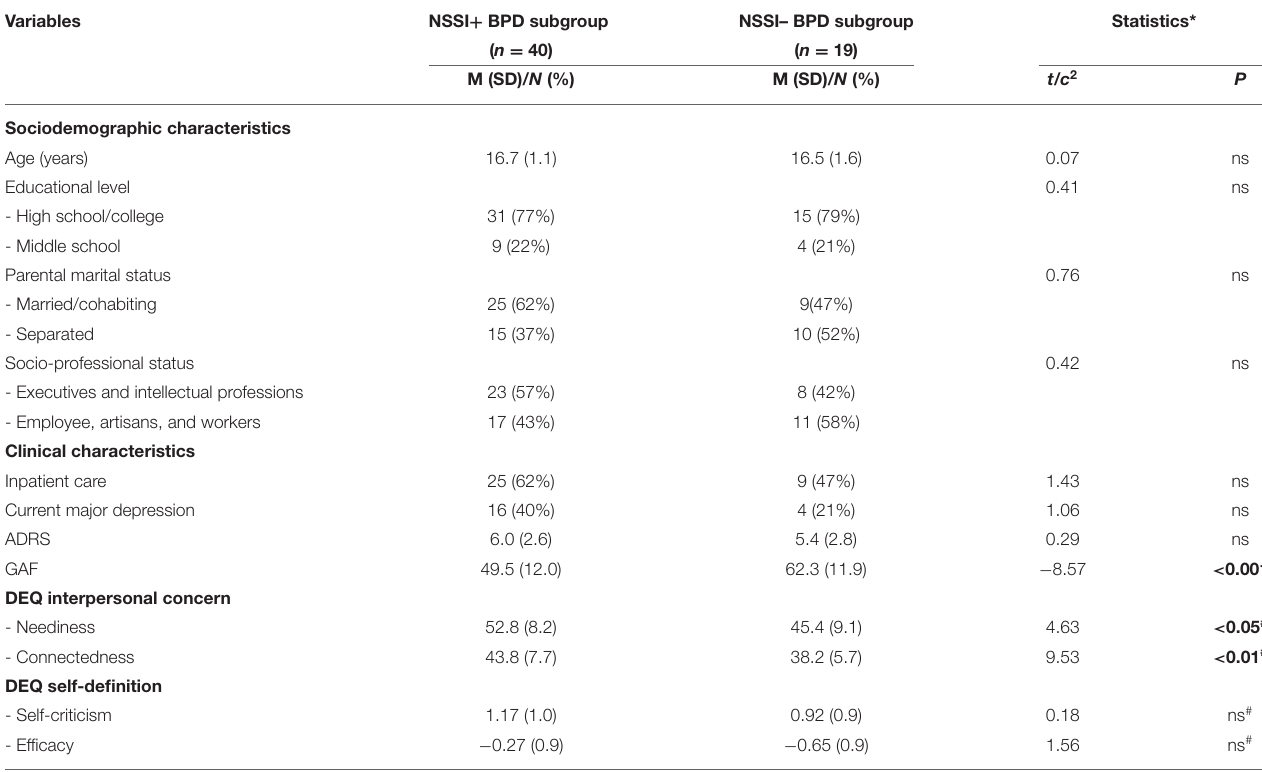
TABLE 2 | Sociodemographic and clinical characteristics of NSSI + and NSSI– BPD